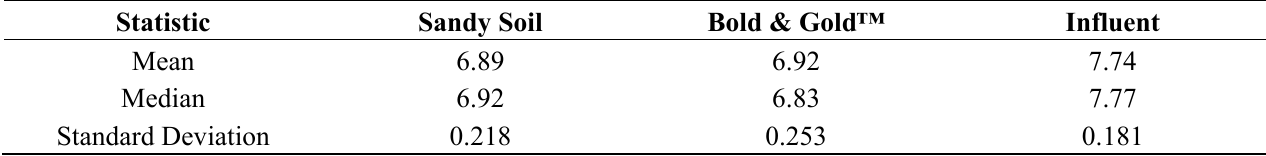
Table 3. Summary of influent and effluent pH